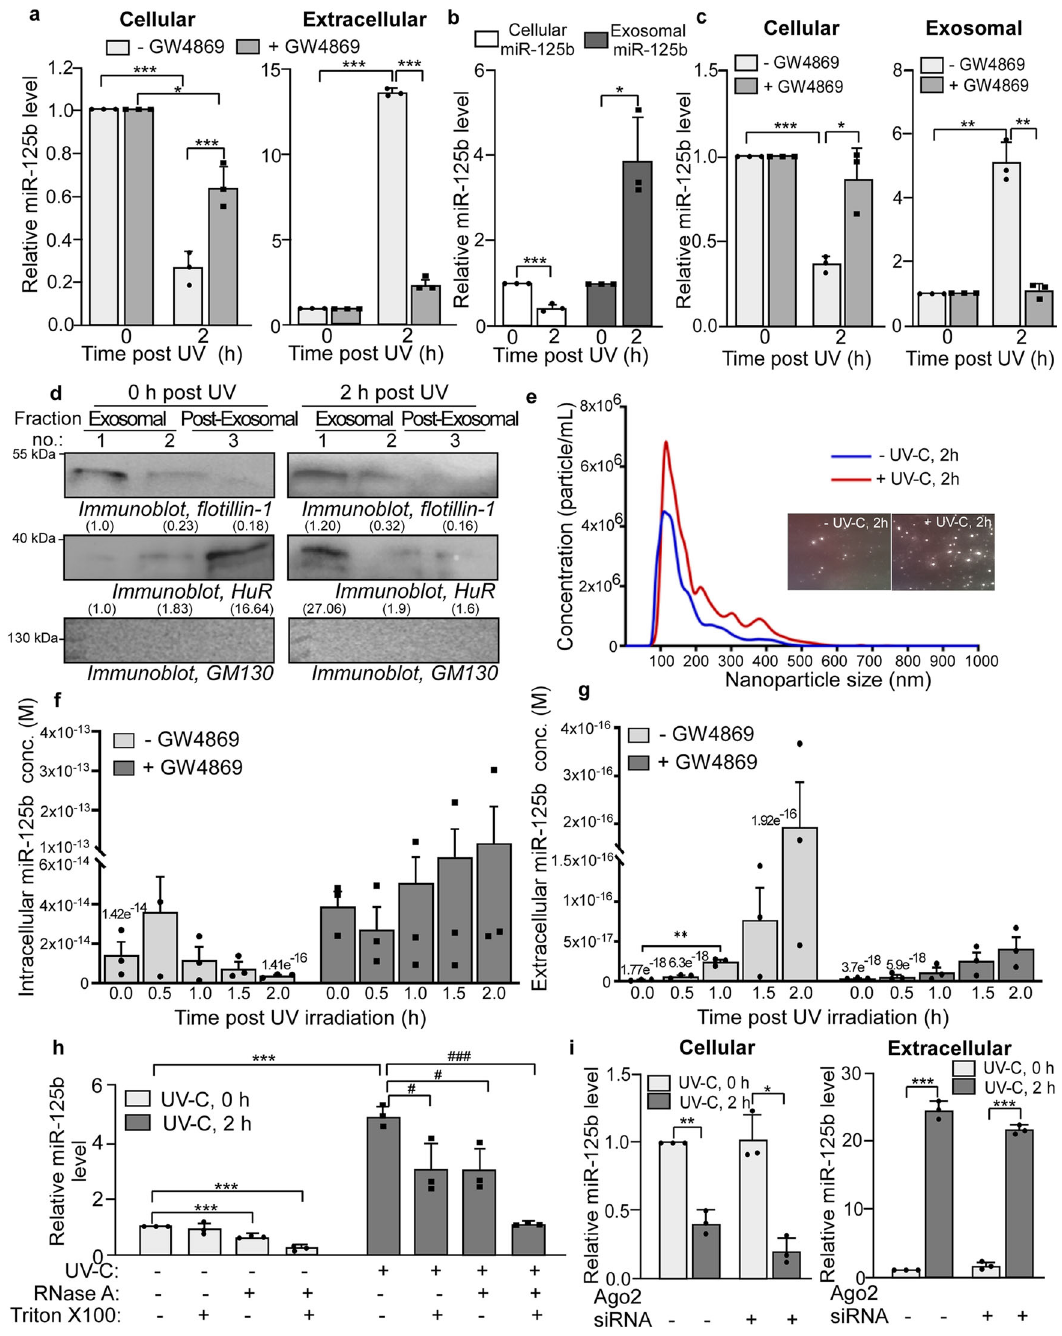
(Fig. 3a, left and middle panels). HuR depletion also caused a signi fi cant decrease in miR-125b level in the exosomal fractions isolated from UV-irradiated cells (Fig. 3a, right panel). HuR was ef fi ciently knocked down by siRNA transfection in both UV- treated and untreated cells (Supplementary Fig. 7). Absolute quanti fi cation of miR-125b also showed a signi fi cant increase in cellular miR-125b in HuR siRNA-transfected cells exposed to UV, similar to that in GW4869 treatment (Fig. 3b, left panel). Con- comitantly, HuR knockdown signi fi cantly reduced the absolute miR-125b level in exosomes from UV-exposed cells, similar to the effect of GW4869 (Fig. 3b, right panel). HuR siRNA transfection did not signi fi cantly change the cellular level of miR-21 in UV- irradiated cells and did not reduce the exosomal miR-21 level in cells exposed to UV, suggesting that HuR did not facilitate the